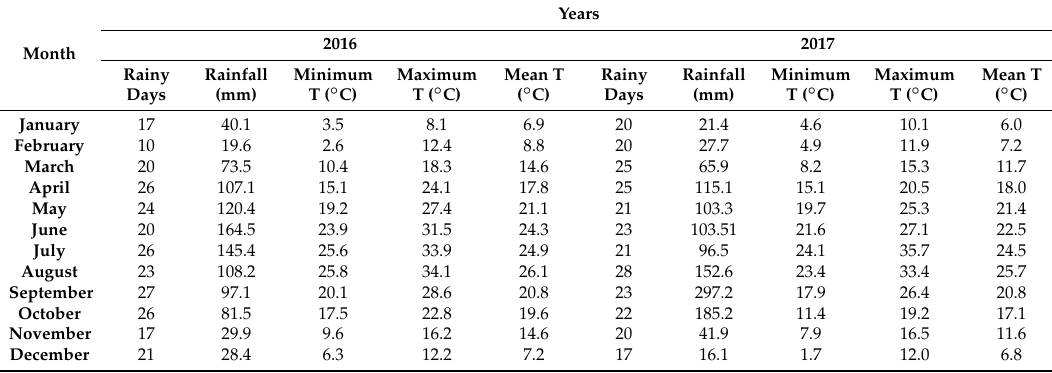
Table 1. Monthly rainy days, rainfall, minimum temperature, maximum temperature, and mean temperature from 2016 to